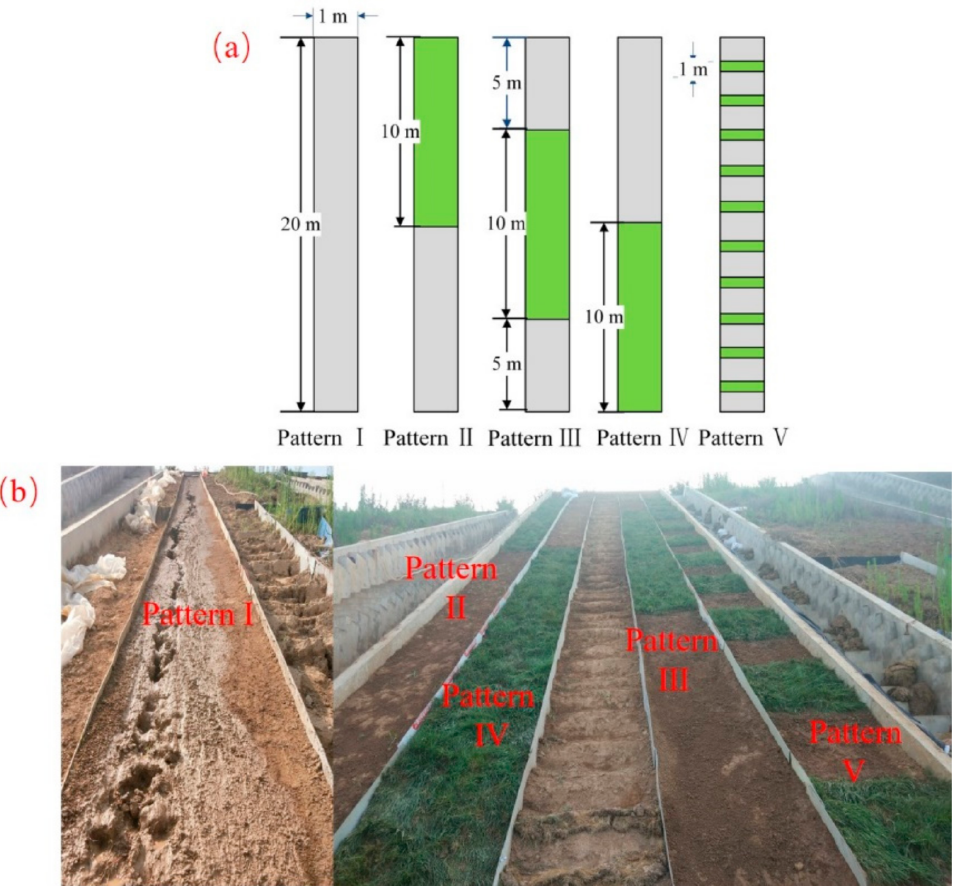
Figure 4. The experimental runoff plots showing the different distributions of grass strip: ( a ) diagram of plot designs; ( b ) grass strip pattern layouts and positions on the